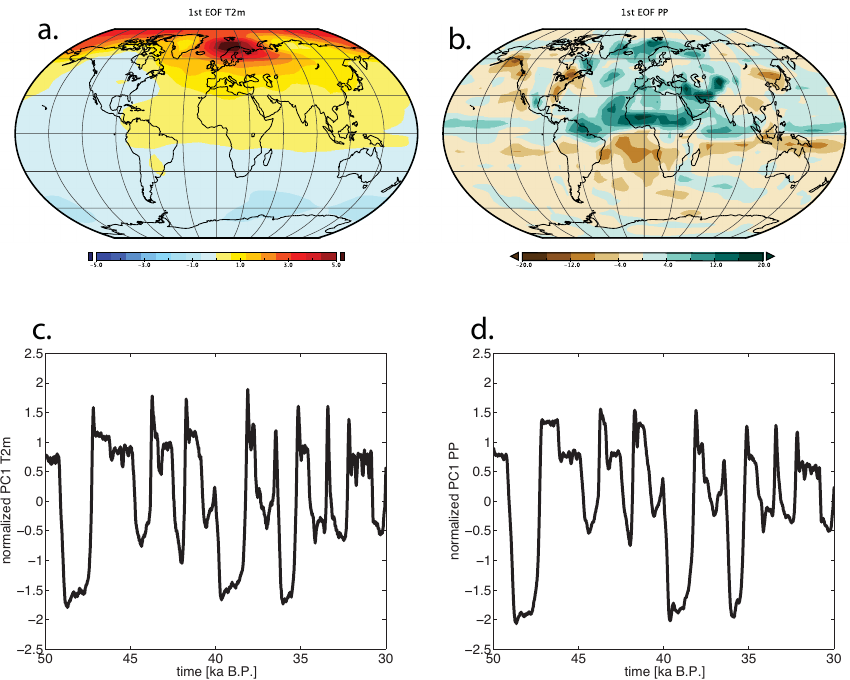
Fig. 4. (a) Pattern of first EOF of detrended 2m air temperature anomalies ( ◦ C); (b) pattern of first EOF of detrended precipitation anoma- lies (cmyr − 1 ); (c) normalized principal component of 1st EOF of detrended 2m air temperature, which explains 64% of the variance; (d) normalized principal component of 1st EOF of detrended precipitation, which explains 16% of the